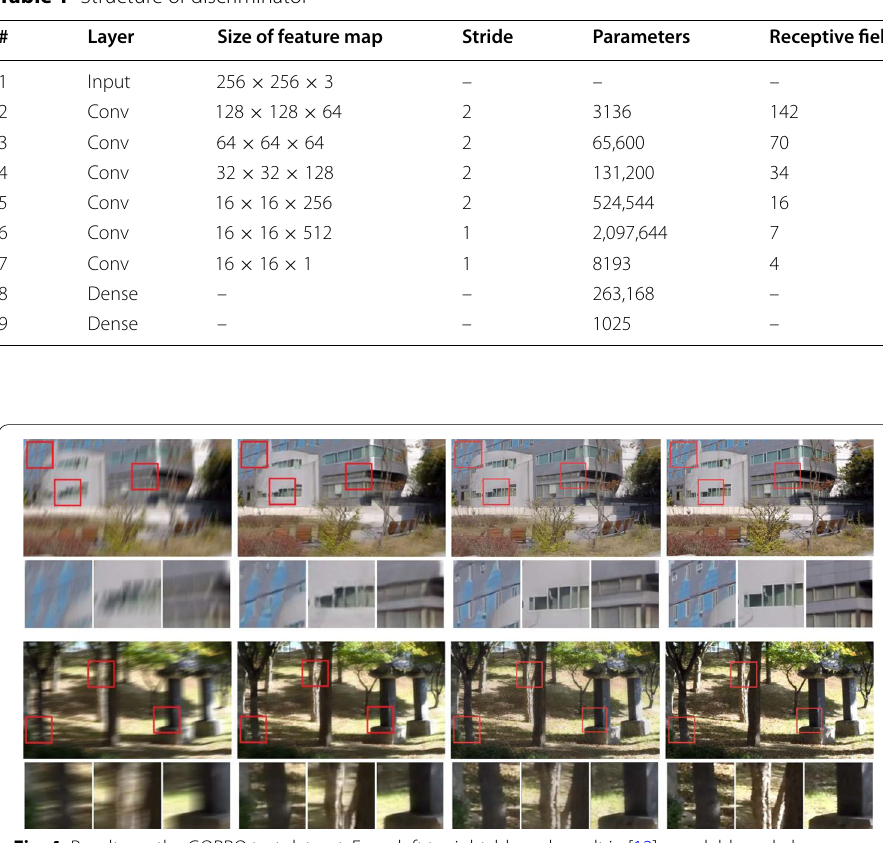
Fig. 4 Results on the GOPRO test dataset. From left to right: blurred, result in [12], our deblurred, sharp